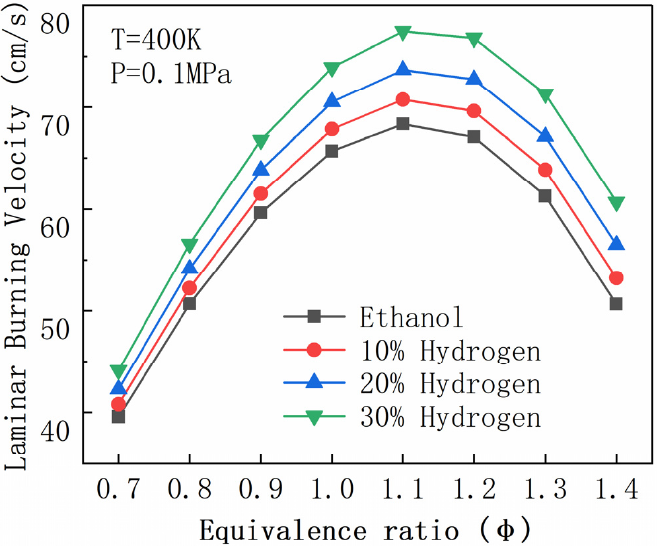
Figure 5. LBVs of fuels with different mixing ratio ( ϕ = 0.7–1.4, T0 = 400 K, P0 = 0.1 MPa).